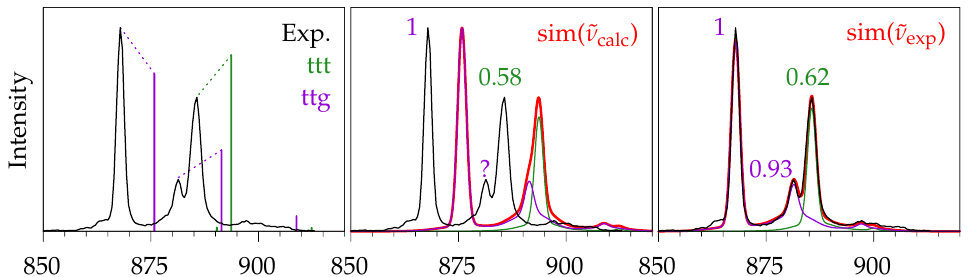
Figure 12. Jet spectrum of methyl butanoate (black, Figure 11, trace (e)) and three differently simulated spectra. Left : Raman cross sections indicated by vertical bars like in Figure 2. Middle : Rovibrational simulation, using calculated harmonic vibrational wavenumbers. The question mark indicates the inability to quantify the weaker ttg signal due to overlapping simulated band contours. Right : Rovibrational simulation, based on experimental vibrational wavenumbers. in the analysis, because it does not seem to be strongly distorted. From these 7 (ttg) +4 686 (ttt) numbers the mean value and the population standard deviation ( 687